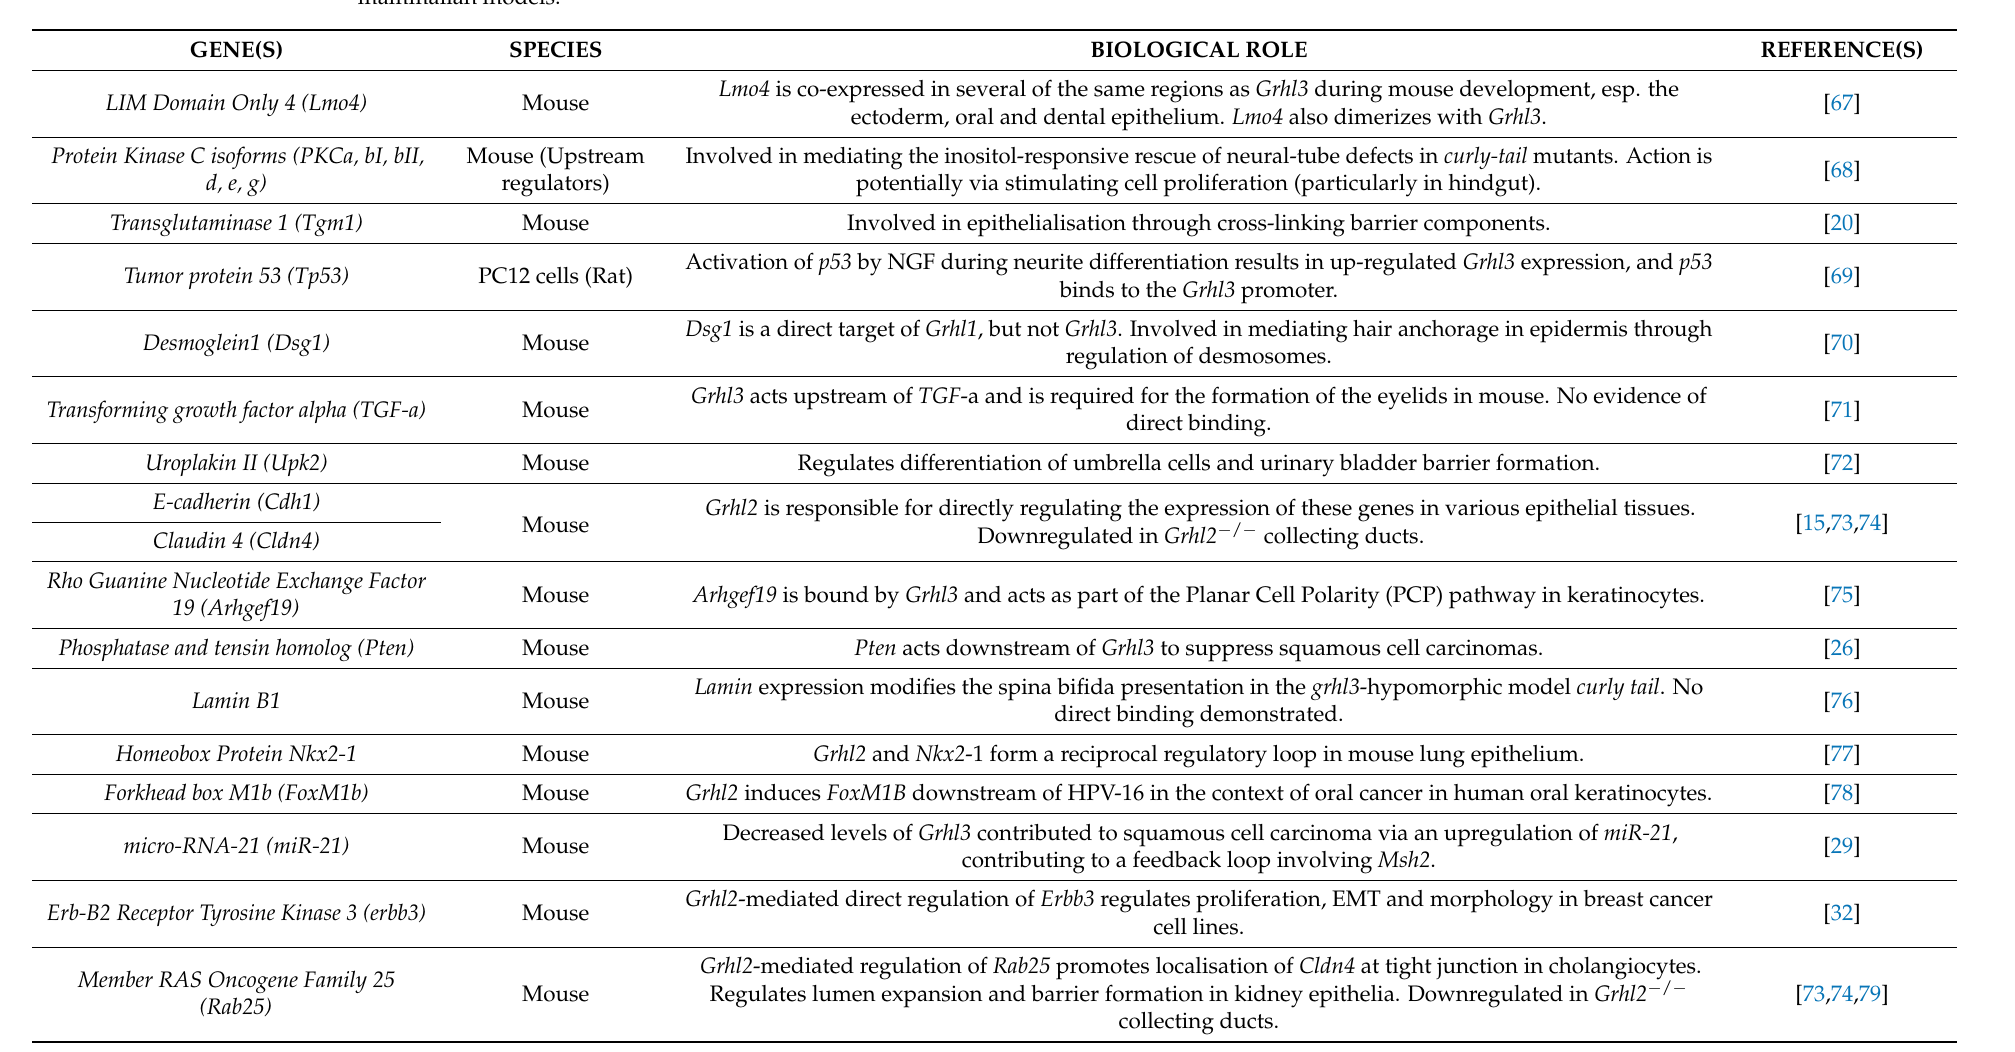
Table 3. Known or hypothesised direct target genes of the Grhl family characterised in rodent models, rodent-derived cell lines, and cell lines derived from other mammalian